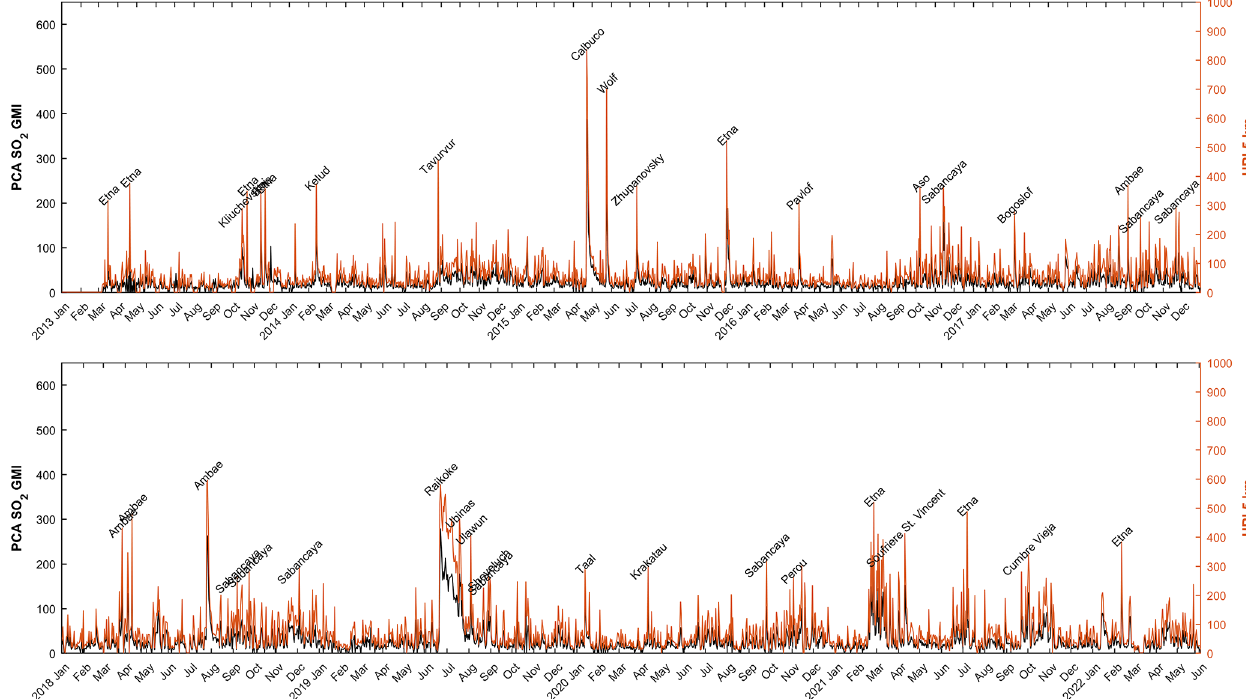
Figure 6. Time series of SO 2 detections from IASI-PCA-GE method (gray) and the SO 2 HRIs at 5km (orange), based on the IASI/Metop-B L1C data for the 2013–2022 period. Only the daily extrema are shown in the time series.